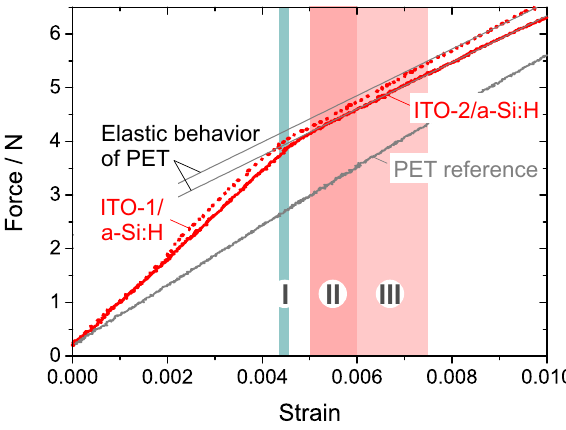
Figure 6. Force–strain curves of two bilayer systems containing ITO-1 (dotted line) and ITO-2 (solid line) and of a PET (HB3) reference substrate (grey solid line). Color bars indicated the range of measured COS values for single films of I: 400nm a-Si:H, II: 200nm ITO-2, and III: 200nm ITO-1. To allow for a better comparison, lines with the slope of the reference curve are superimposed to the bilayer